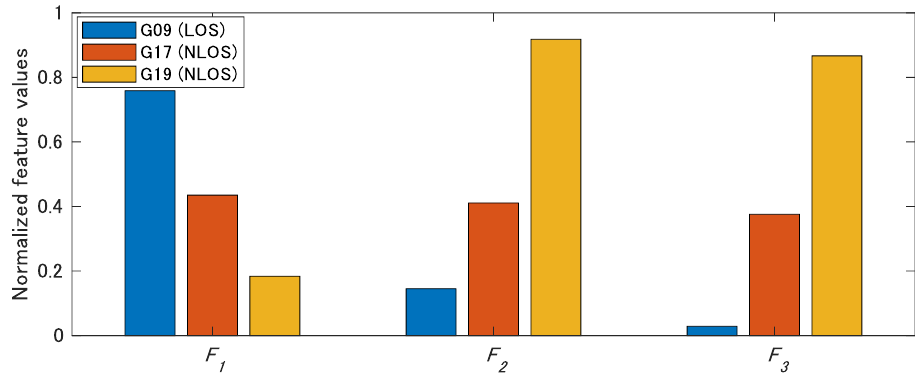
Figure 12. Evaluation of the extracted NLOS features of SVM. NLOS features F 1 , F 2 , and F 3 are calculated from Equations (10)–(12), respectively. There is a difference between the LOS and NLOS satellites in all features.